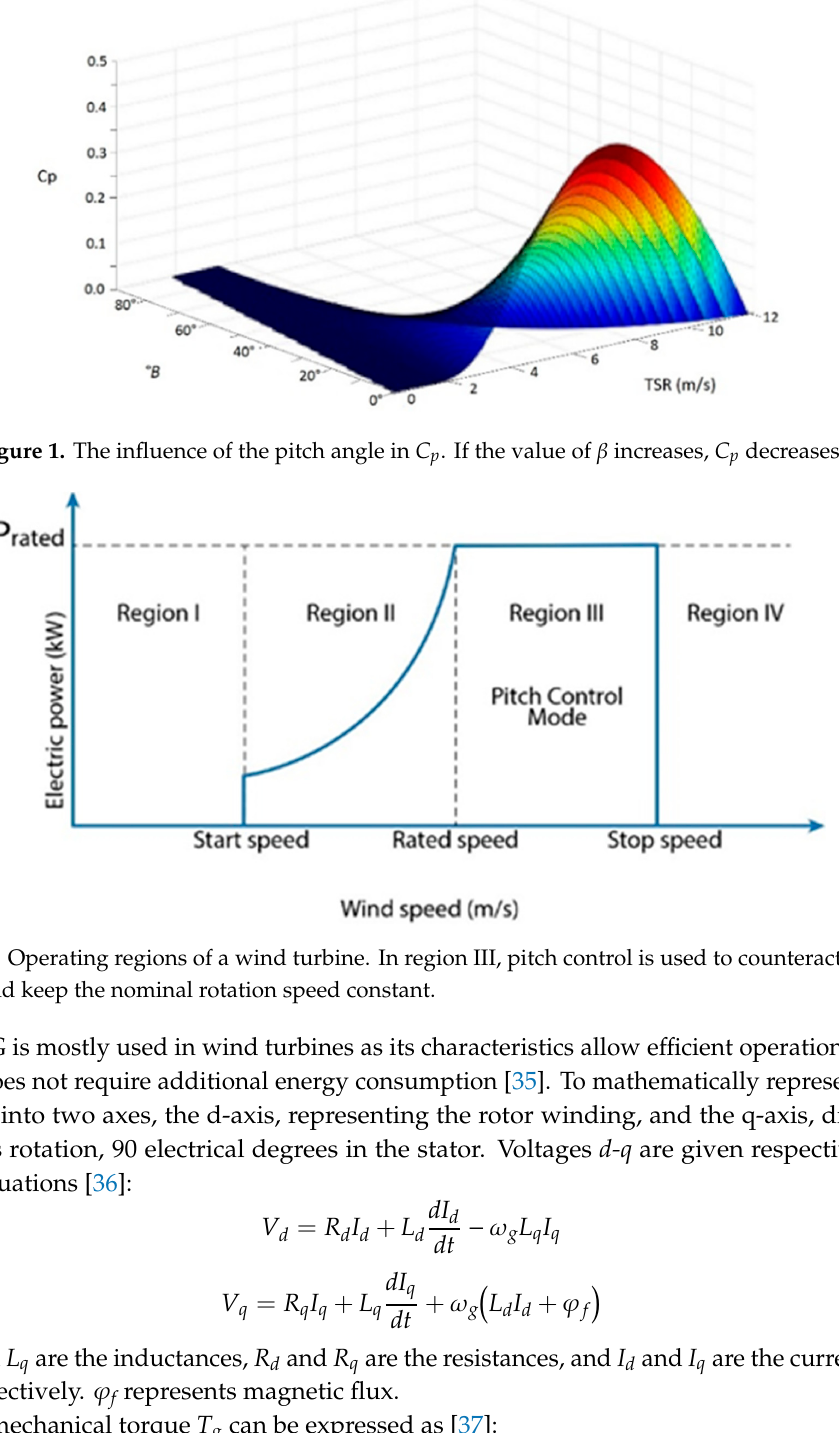
Figure 2. Operating regions of a wind turbine. In region III, pitch control is used to counteract strong winds and keep the nominal rotation speed constant.